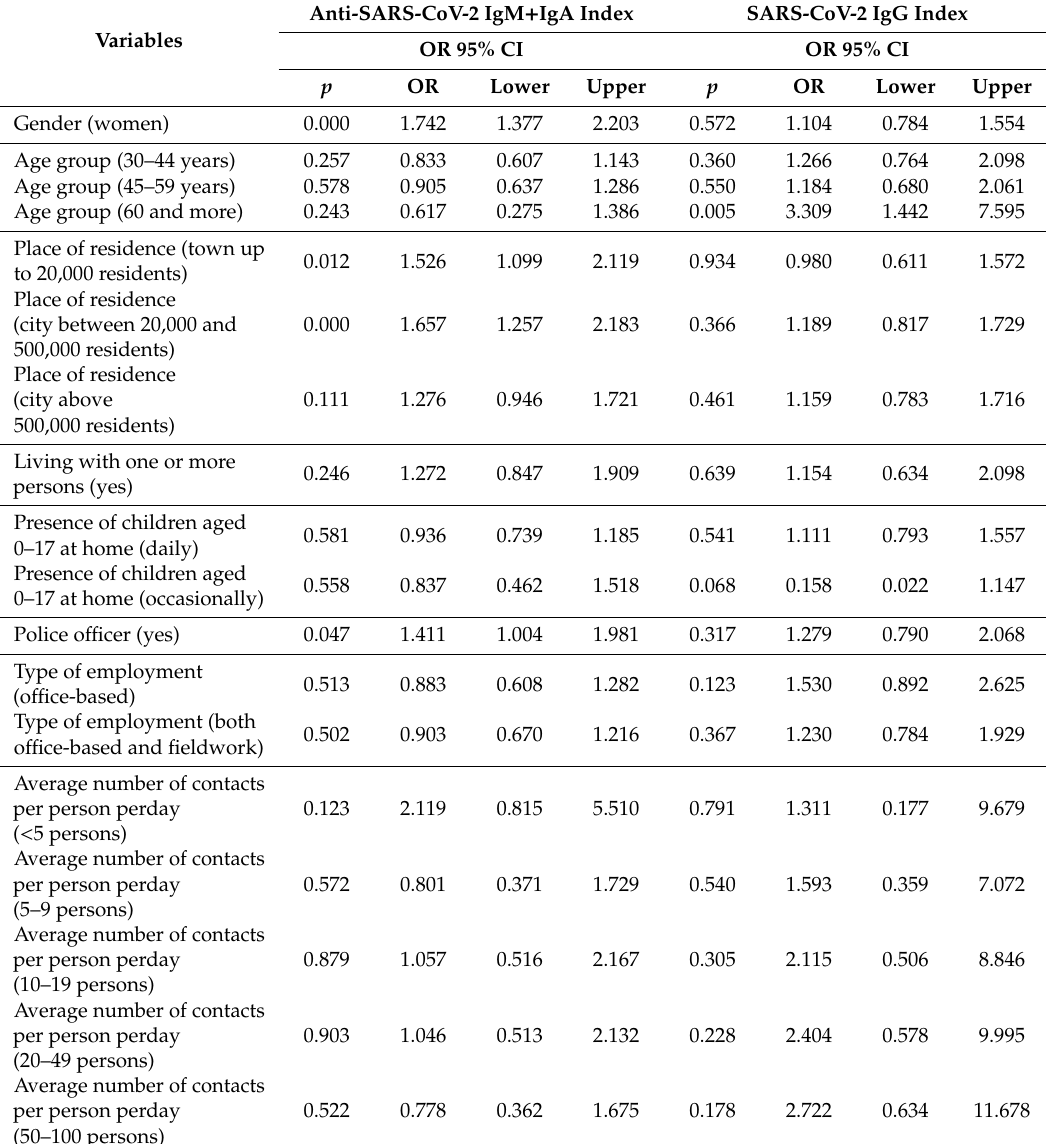
Table 3. E ff ect of risk factors on positive results of anti-SARS-CoV-2 IgM + IgA ( > 8) and IgG indexes ( > 5)—a multivariate logistic regression